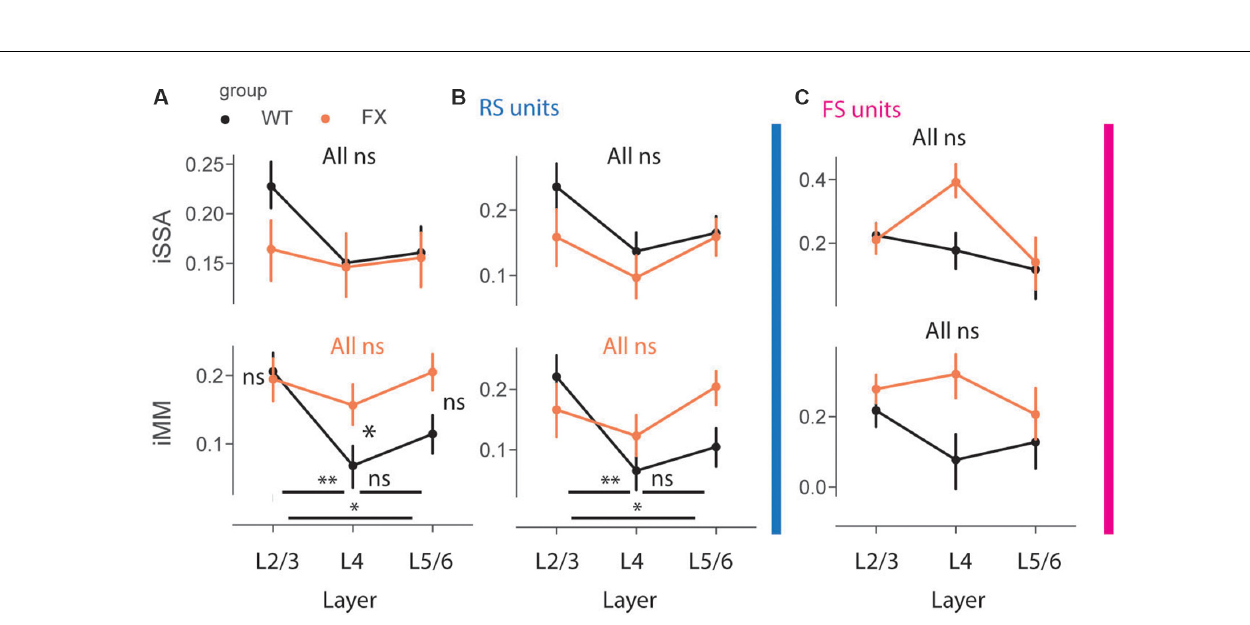
responses did not reveal any differences between WT and FX stimulus onset from both genotypes. Using an elbow method, we determined that k = 4 was an optimal number of groups ( Figure 8B ). Given that genotype was independent of clustering, we were able to compare responses between WT and FX within each k -means group. Clustering revealed four different types